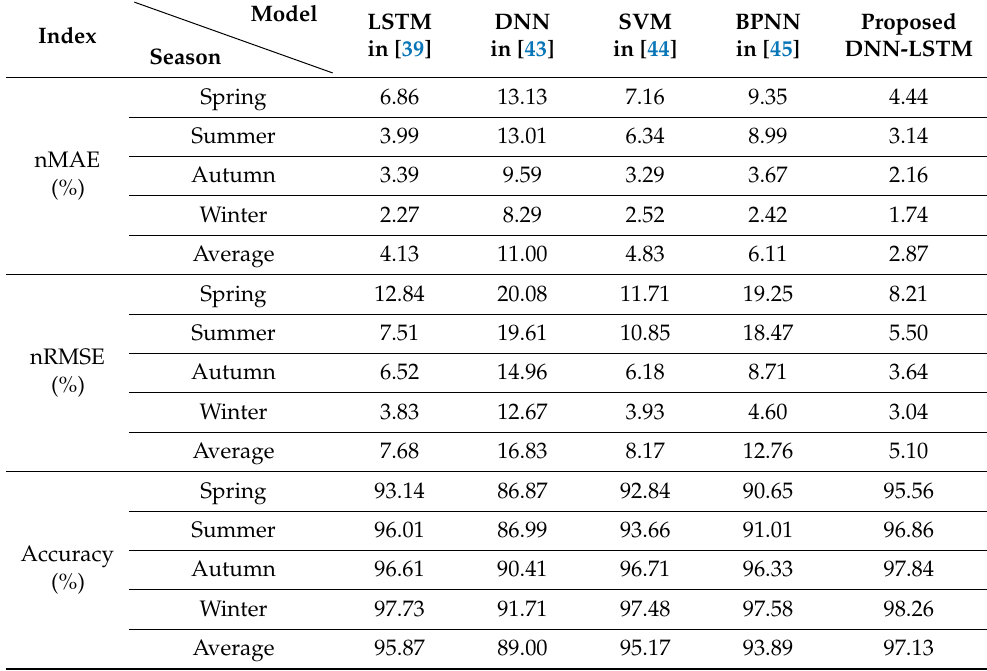
Table 9. Comparisons of performance indicators of five forecasting models for solar power plant